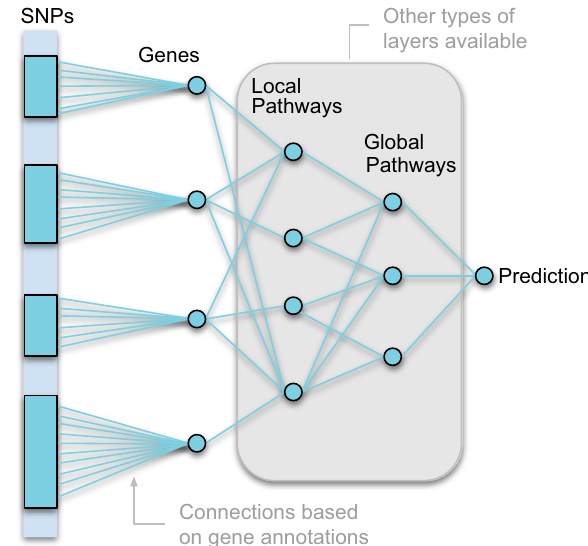
Fig. 1 Overview of the GenNet framework. Neural networks are created by using prior biological knowledge to de fi ne connections between layers (i.e., SNPs are connected to their corresponding genes by using gene annotations, and genes are connected to their corresponding pathway by using pathway annotations). Prior knowledge is thus used to de fi ne each connection, creating interpretable